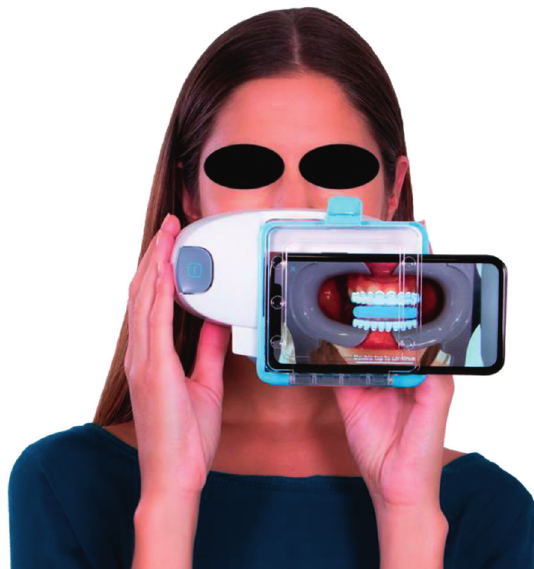
Figure 2: Dental Monitoring system. This smartphone-based app allow patients to scan directly their teeth and provide instantaneous feedback of treatment progress to the clinicians and orthodontic office. The patient insert the smartphone into the ScanBox that allows a more predictable scan